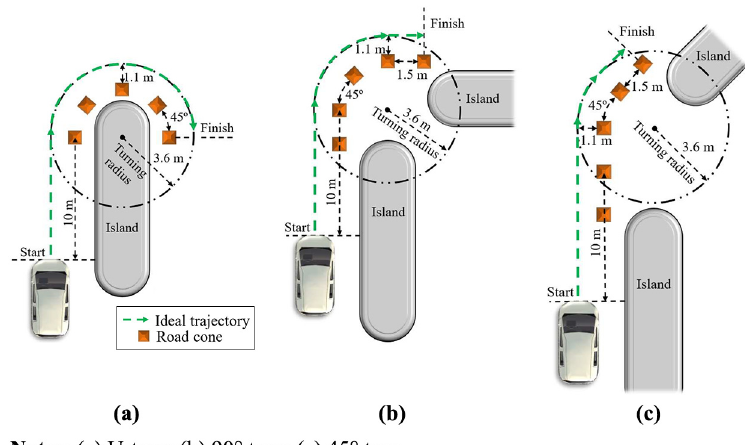
Figure 5 Three driving simulator scenarios